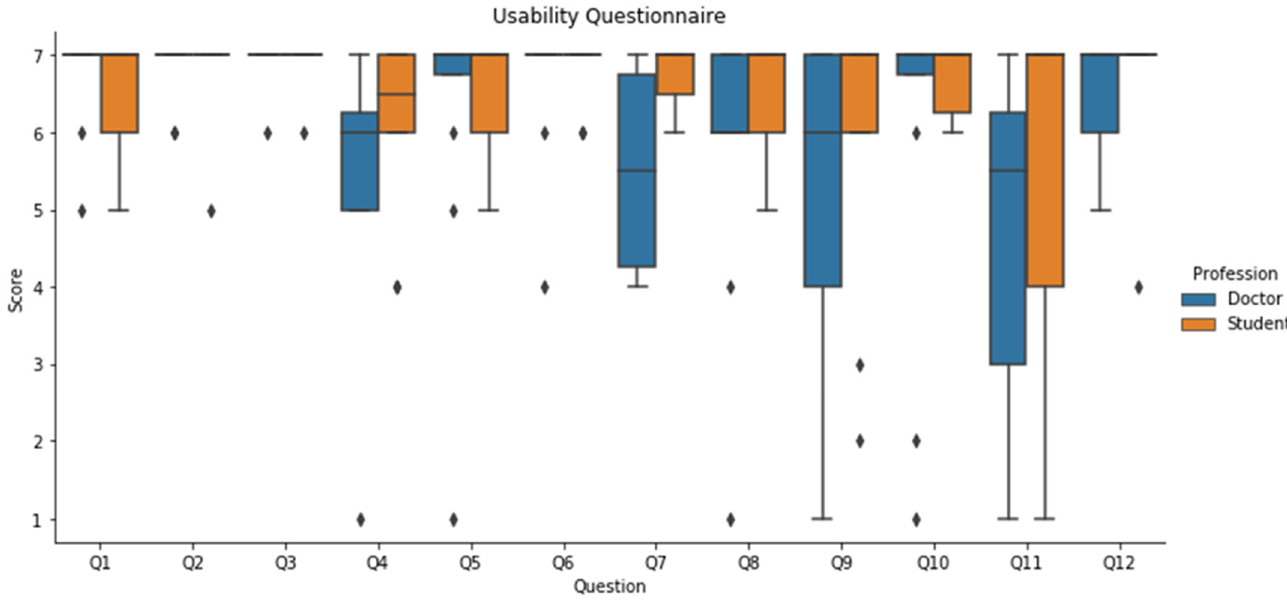
Figure 6. Usability post-simulation questionnaire. The values shown are scores provided by all the participants following the 7-points Likert scale. The responses provided by doctors are provided in blue and the ones provided by medical students, are shown in orange.